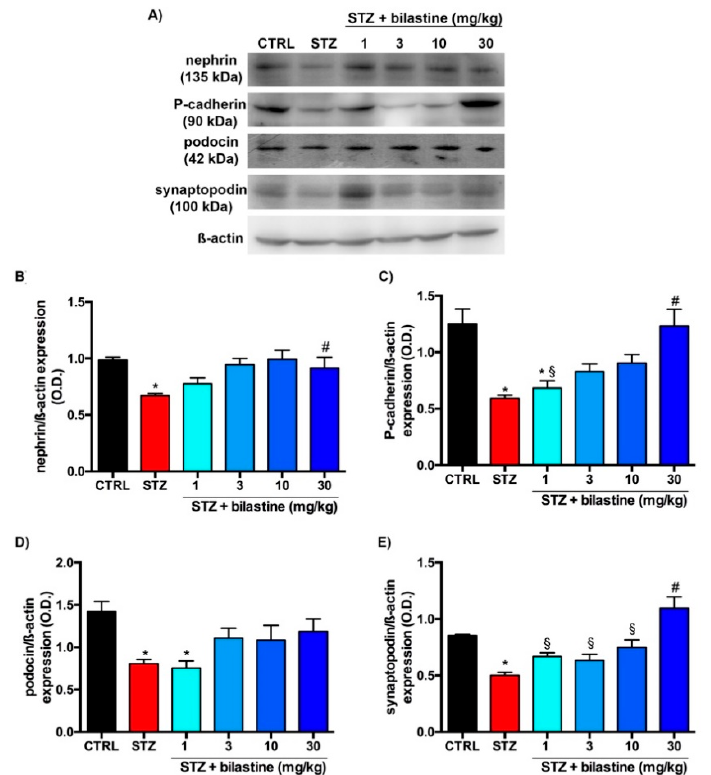
Figure 5. E ff ect of bilastine on podocyte protein expression. Representative radiograph of nephrin, P-cadherin, podocin, and synaptopodin expression in kidney tissue determined by immunoblotting ( A ). The densitometric analysis of nephrin ( B ), P-cadherin ( C ), podocin ( D ), and synaptopodin ( E ) was performed and expression levels, normalized to β -actin, are expressed as the mean ± S.E.M. of 5 animals/group; * p < 0.05 vs. CTRL, # p < 0.05 vs. STZ; § p < 0.05 vs. STZ + bilastine 30 mg/kg.